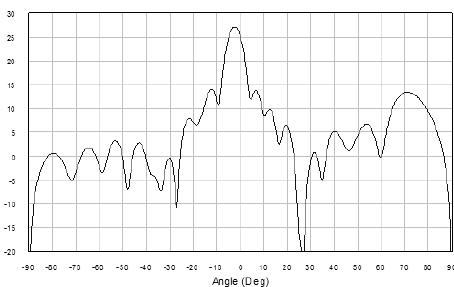
Fig. 7. Radiation pattern for beam deflection in the azimuthal plane.